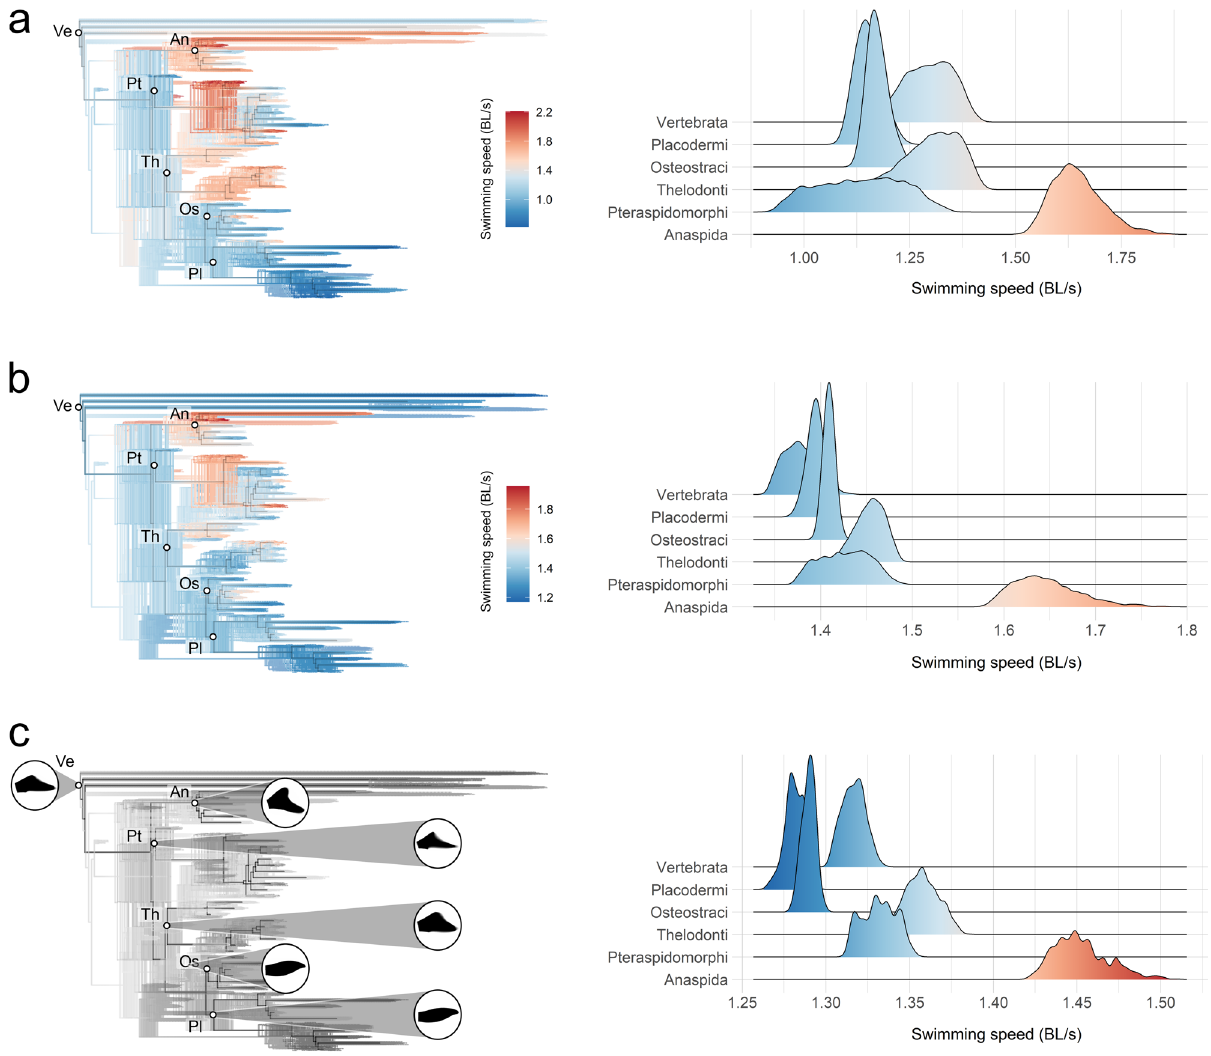
Fig. 2 Ancestral cruising swimming speeds of Palaeozoic early vertebrates. Results derived from ancestral character state reconstruction of ( a ) non-size- normalized speeds, ( b ) size-normalized speeds, and ( c ) caudal fi n morphology. The outcomes of each analysis are summarized both as density trees with mapped ancestral speeds (in a and b ) and caudal fi n morphologies (in c ); and density plots showing the ancestral speeds predicted for the main clades (left and right panels, respectively). Density trees include a subsample of 100 trees randomly selected from the original pool, while density plots are based on the whole pool of trees. Black outlines in ( c ) represent the average of all the caudal fi n morphologies inferred for each selected node. Swimming speeds are in body lengths per second (BL/s). Taxa: Ve Vertebrata; An Anaspida; Pt Pteraspidomorphi; Th Thelodonti; Os Osteostraci; Pl